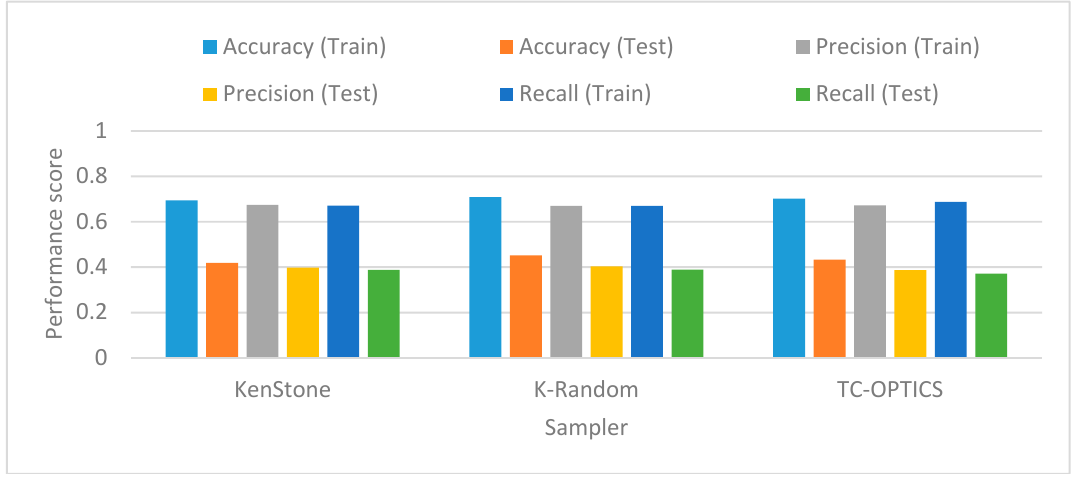
Figure 4. Illustrating the impact over performance scores for the proposed sampling approaches.